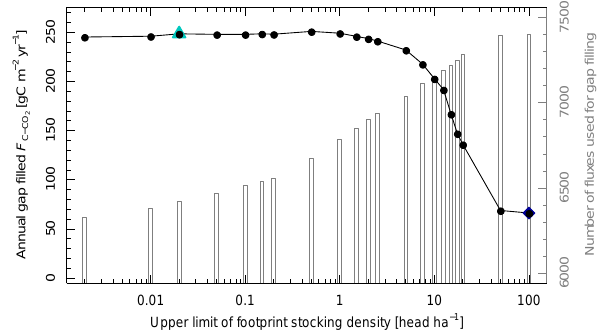
Figure 5. Effect of CO 2 flux selection based on the observed cow stocking density within the flux footprint on the annual CO 2 ex- = − NEE) and number of fluxes used for the gap change ( F C-CO 2 filling (bars). The dark blue diamond symbol represents F C-CO , 2 , tot the light blue triangle represents F C-CO 2 , past